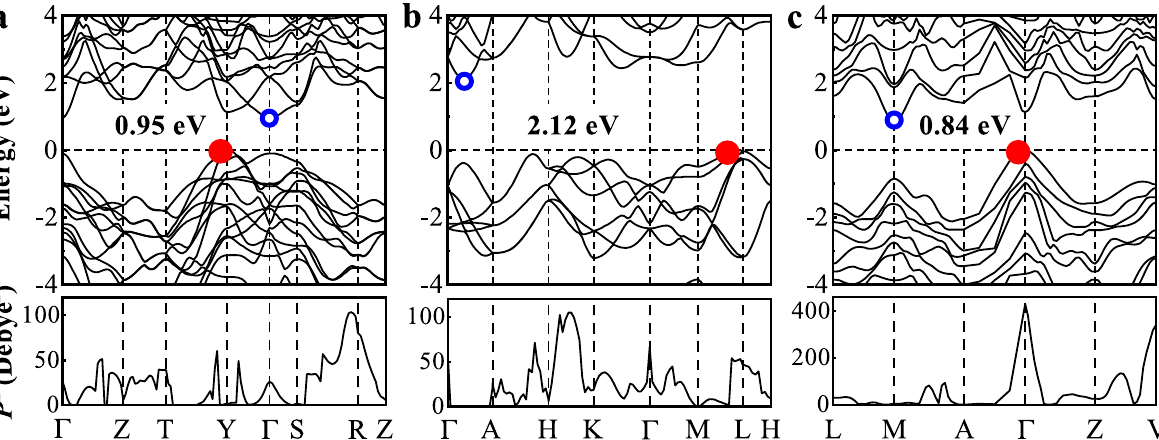
Fig. 6 Electronic properties of the Si allotropes. Electronic band structures of a oC24-Si, b tP6-Si, and c mC8-Si at 0 GPa calculated based on the HSE06 functional. The lower panels in each fi gure are the square of the transition dipole